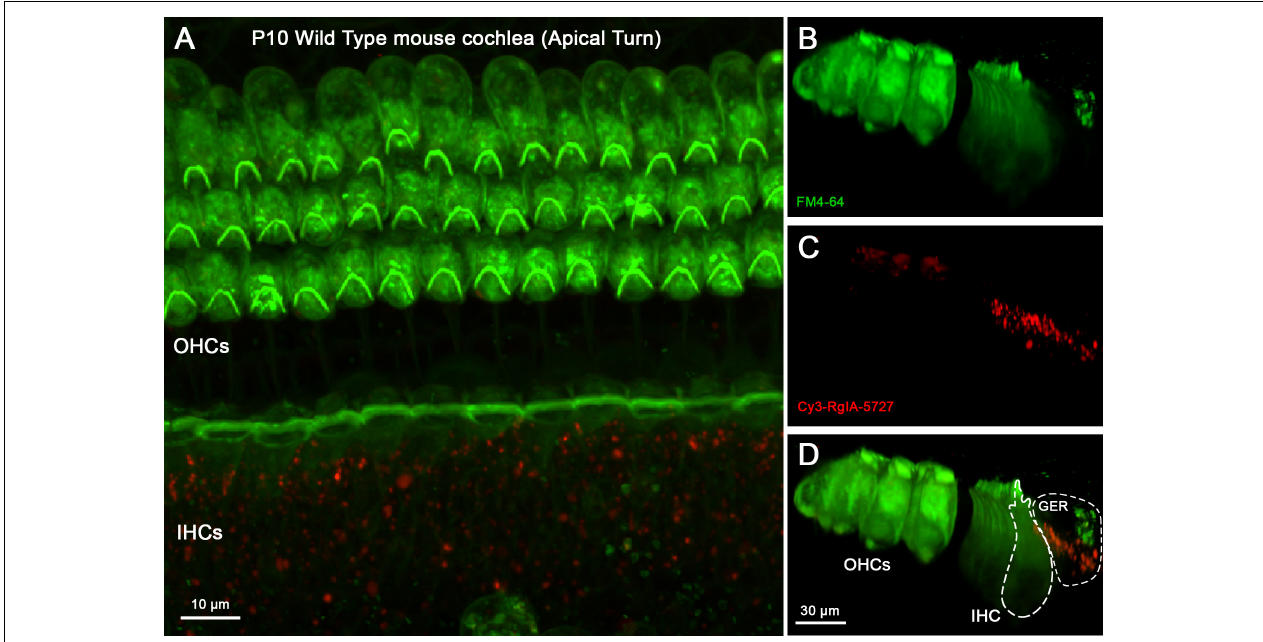
FIGURE 8 | Cy3-RgIA-5727 labeling in P10 WT mouse cochlea pre-exposed to non-conjugated RgIA-5474. At this age one can expect efferent synapses on IHCs and OHCs. (A) Maximum intensity projection (MIP) from the apical surface of the cochlea. (B) Optical yz-plane view of cochlea (MIP), three rows of OHCs on left, single row of IHCs on right, green FM4-64 accumulation. (C) Cy3-RgIA-5727 in yz-plane (MIP). (D) Merged view of FM4-64 and Cy3-RgIA-5727 (MIP). No Cy3 puncta are found in the synaptic regions of IHCs (outlined with dashed lines) or OHCs but Cy3 puncta are seen in the greater epithelial ridge (GER, outlined with dashed lines). Images exemplify results obtained from two cochleas from two mice. See Supplementary Video 5 .